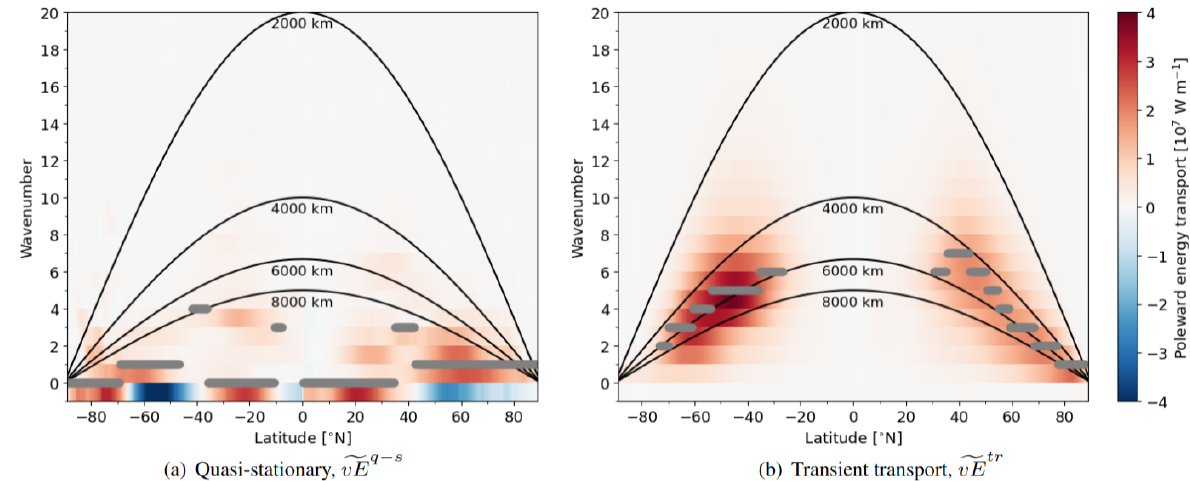
Figure 2. The annual-mean, zonal-mean Fourier-decomposed poleward transport of energy from ERA5 by each wave at all latitudes. Decom- position of the (a) quasi-stationary and (b) transient energy transport. The wavenumbers corresponding to wavelengths of 2000, 4000, 6000, and 8000km are depicted by black curves. The first and last curve separate the transport into the mesoscale, synoptic scale, and planetary scale. At each latitude the wave of maximal poleward energy transport is displayed with a grey dot. The dot is not displayed at latitudes where this wave is responsible for less than 5% of the total quasi-stationary/transient transport of the latitude with maximum